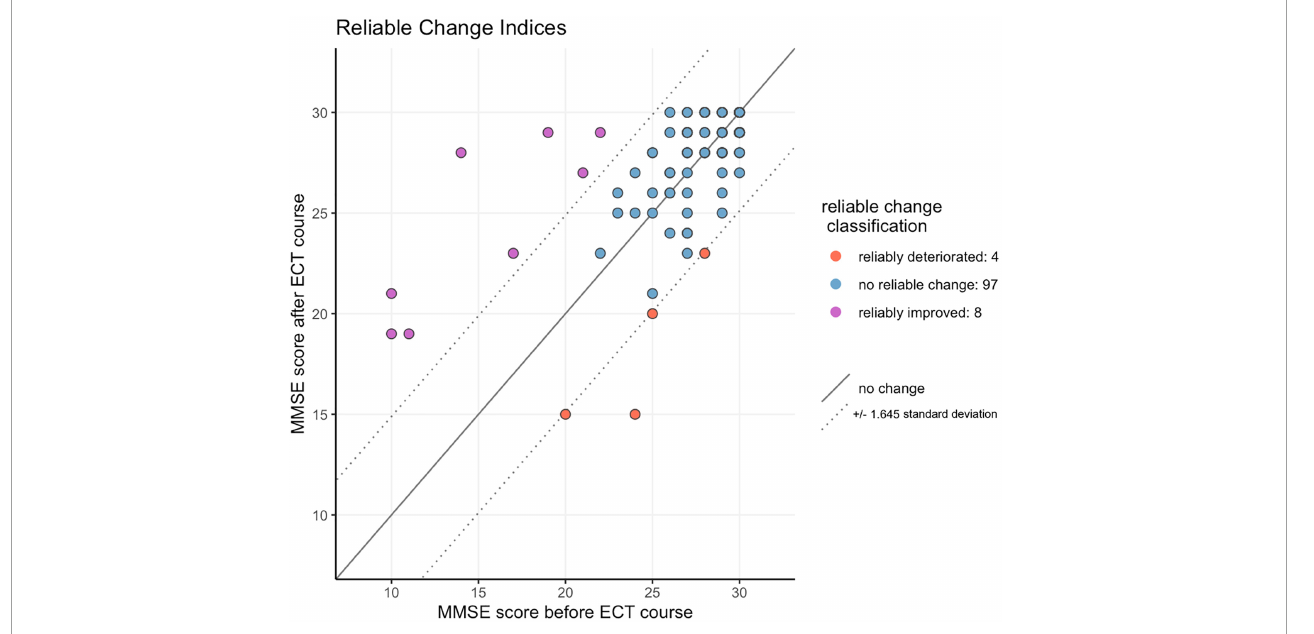
FIGURE2 Reliable change in cognition score after the ECT-course compared to